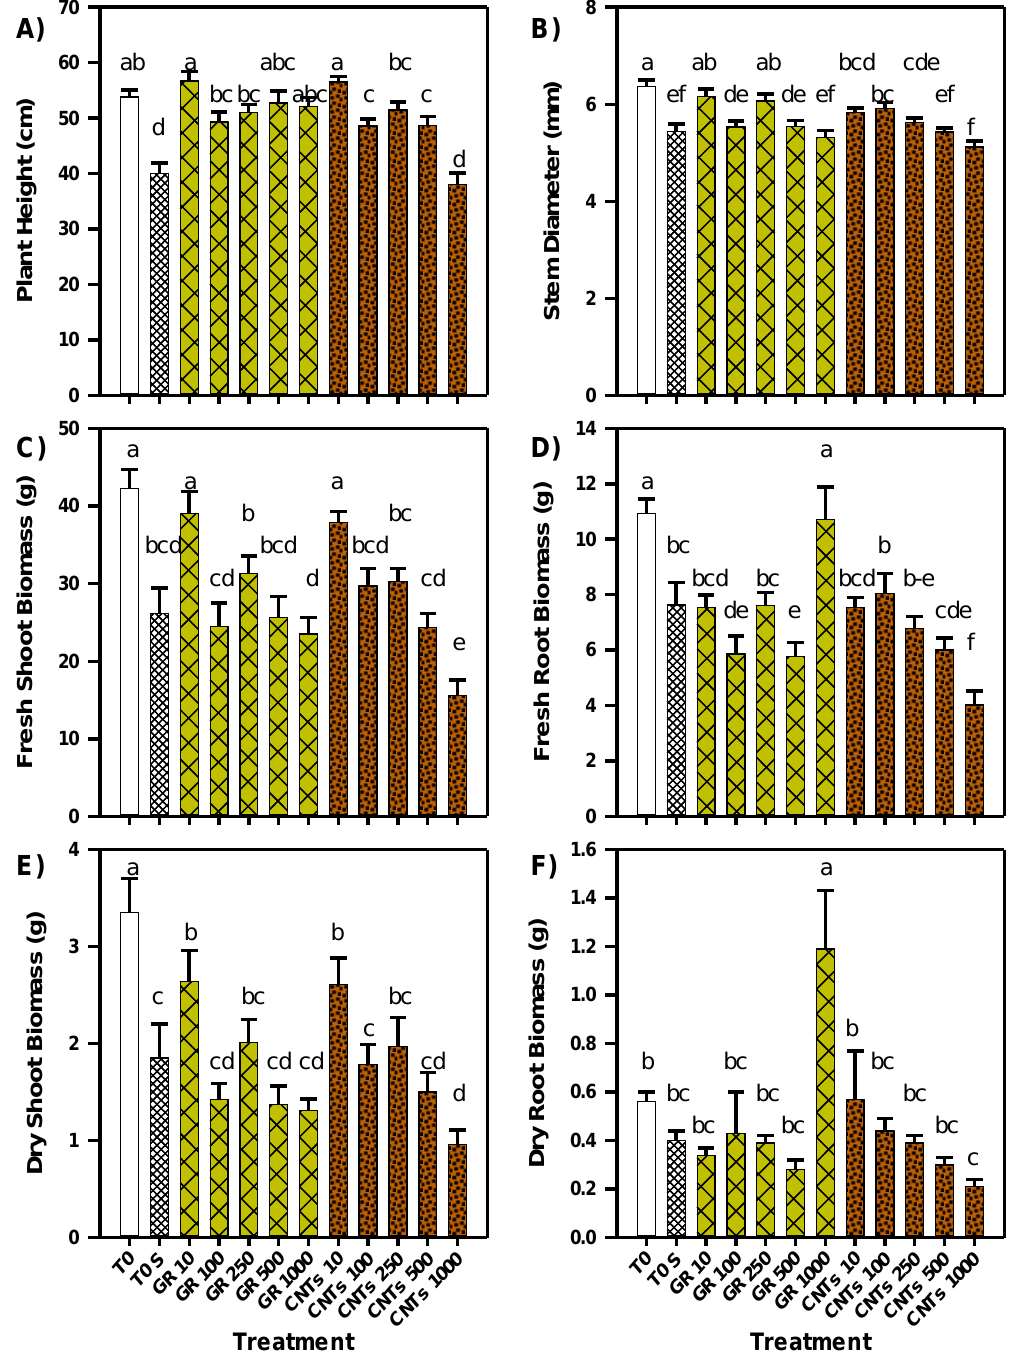
Figure 2. Agronomic variables evaluated in tomato seedlings treated with carbon nanomaterials. Each data point is the average of ten replicates ± standard error. Different letters indicate significant differences between treatments according to Fisher’s least significant difference test ( p ≤ 0.05). T0: absolute control. T0 S: sonicated control. GR: graphene. CNTs: carbon nanotubes. 3.3. Content of Photosynthetic Pigments of Tomato Seedlings.